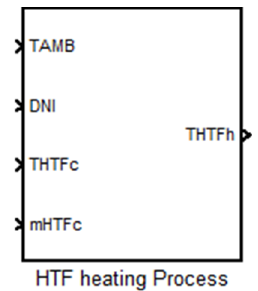
Figure 14. HTF heating process.